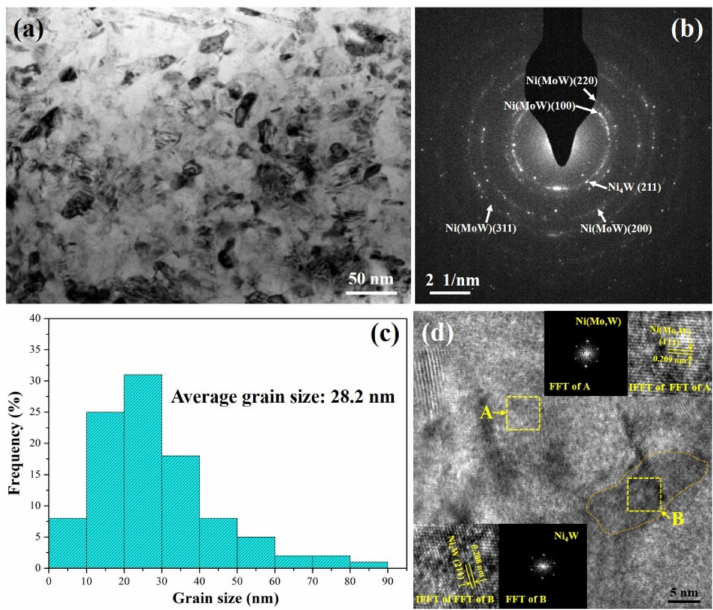
Figure 5. TEM images of the Ni-Mo-W coating annealed at 400 ◦ C: ( a ) Bright-field image, and ( b ) corresponding selected area diffraction (SAD) is shown in inset of ( a ); ( c ) Grain size distribution represented in histogram; ( d ) HRTEM image, and insets of ( d ) are respectively the fast Fourier transformation (FFT) results and corresponding inverse fast Fourier transform (IFFT) results of the square regions marked A and